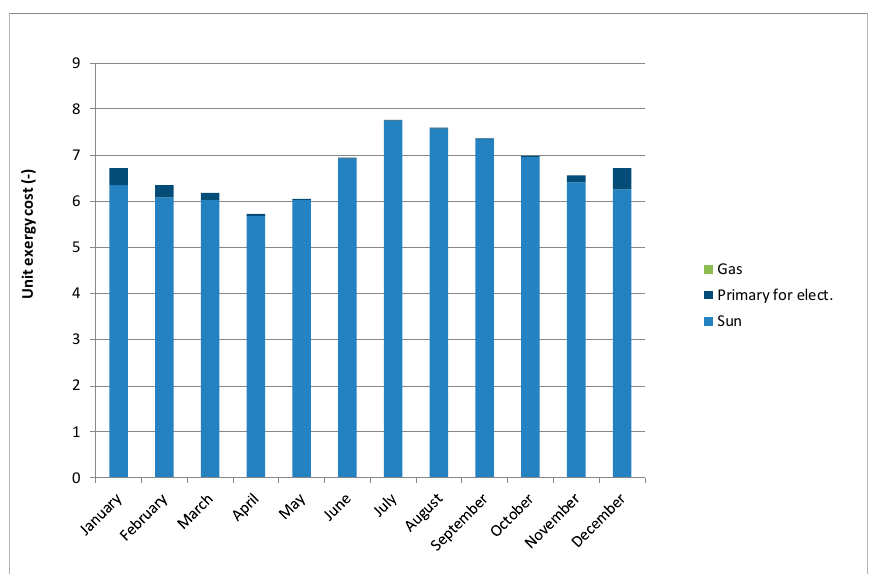
Figure 18. PVT: Cost formation by source.